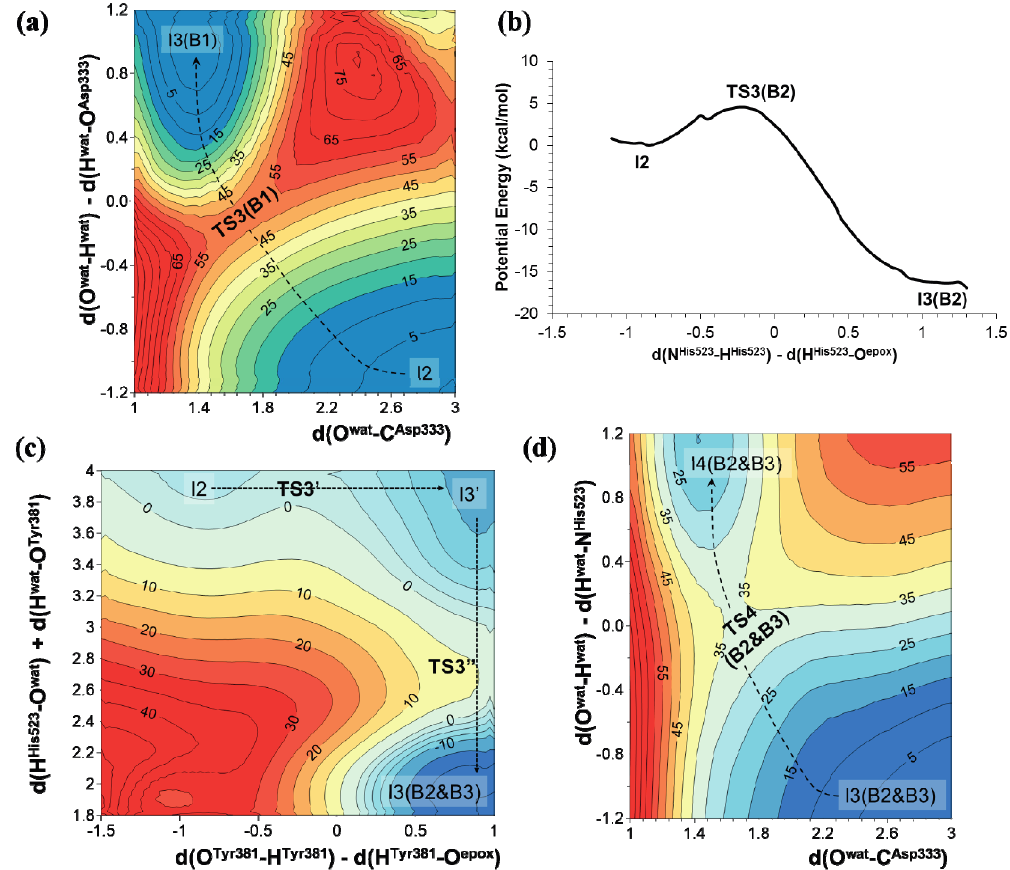
Figure 3. AM1 PESs for hydroxyl formation from oxyanion tetrahedral intermediate of t-DPPO(1) through different possible mechanisms: ( a ) nucleophilic attack of a water molecule on the carbonyl carbon atom of Asp333; ( b ) direct proton transfer from His523 to the negatively charged oxygen atom of epoxide; and ( c ) proton transfer from His523 to the negatively charged oxygen atom of epoxide through a water molecule and Tyr381; ( d ) AM1 PES corresponding to the nucleophilic attack of a water molecule and the proton transfer to His523 from hydroxyl intermediate. All distances are in Å and energies in kcal·mol − 1